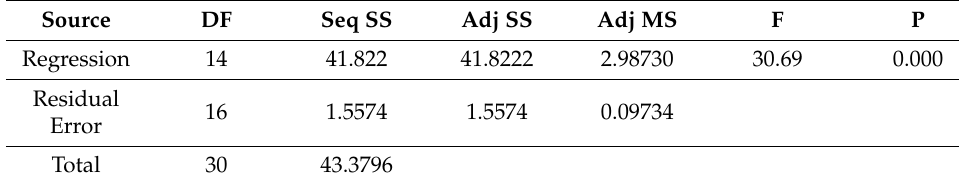
Table 13. Analysis of variance for thermal conductivity (W/m · K).